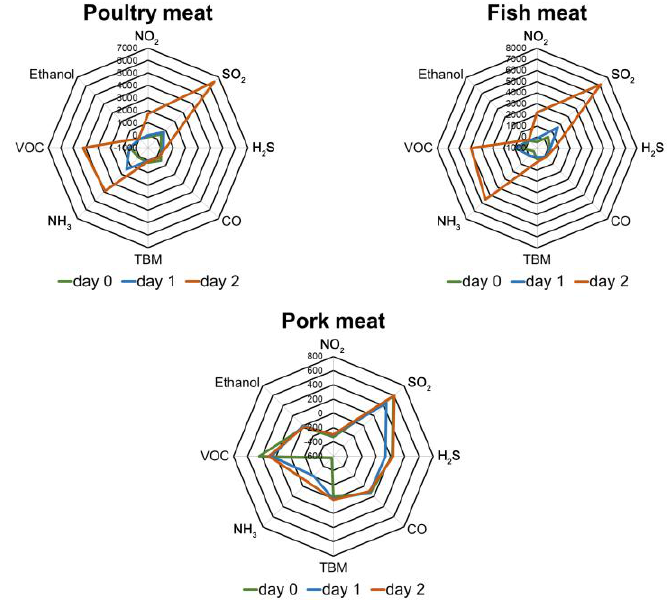
Figure 4. Radar plots for fish, poultry, and pork samples at different time of incubation.